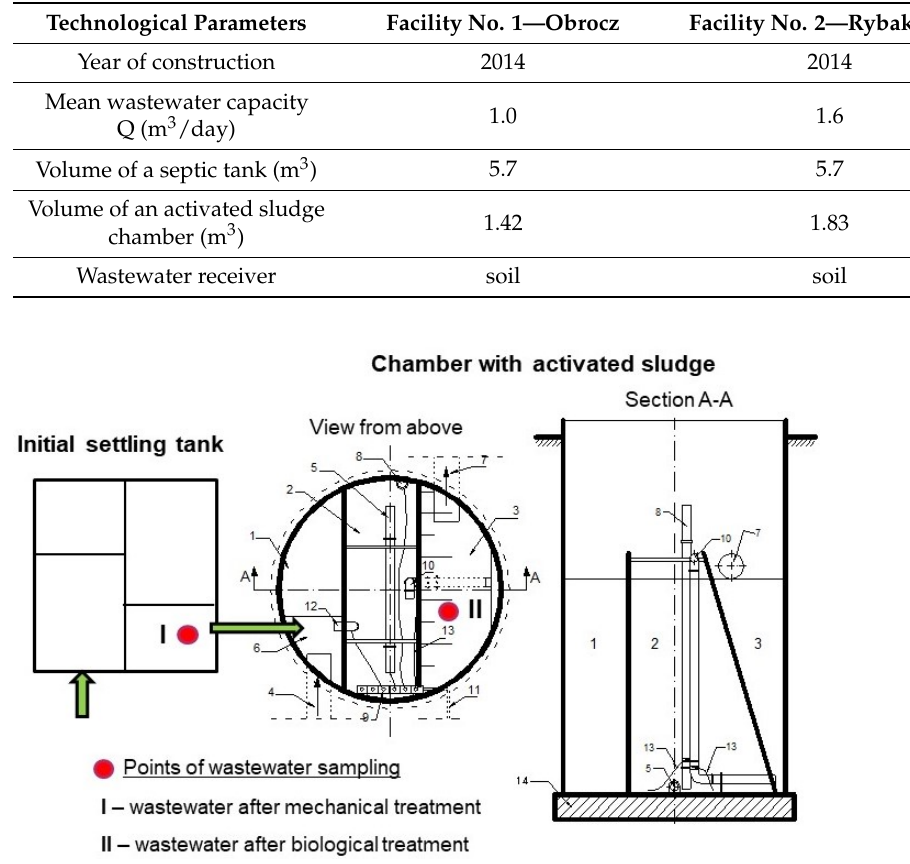
Figure 1. Technological scheme of the household wastewater treatment plants (WWTPs) in the area of the Roztocze National Park (RNP) (prepared on the basis of [43]). Scheme: 1—denitrifica- tion chamber; 2—nitrification chamber; 3—separation chamber; 4—wastewater inlet; 5—tube dif-